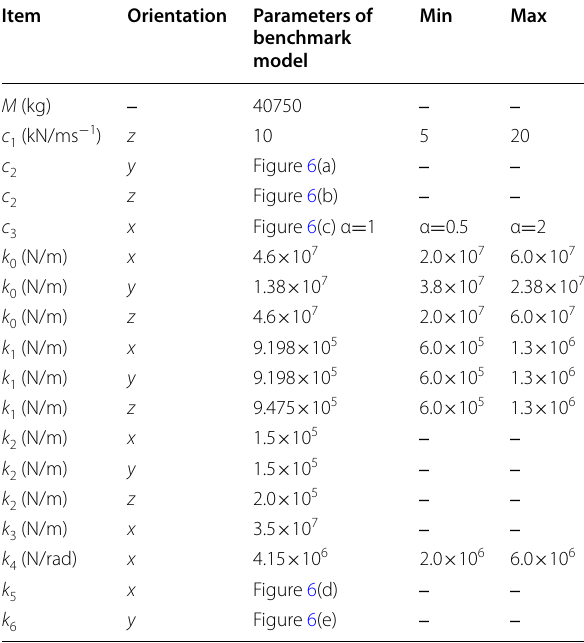
Table 3 The main parameters of the benchmark model and the range of each design variable